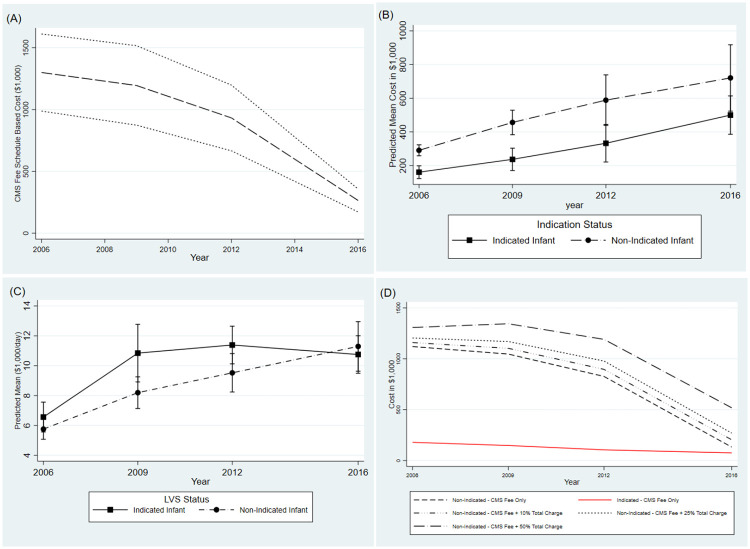
Trends in cost associated with preterm brain MRI across cycles.Panel A: Total Inflation Corrected CMS Fee Schedule Based Cost with 95% CIs for Preterm Brain MRI by KID cycle. Panel B: Unadjusted Mean Total Charge across cycles by Indication Status. Panel C: Length of Stay Adjusted Mean Total Charge across cycles by Indication Status. Panel D: Sensitivity Analysis for Additional Cost Related to Preterm Brain MRI.